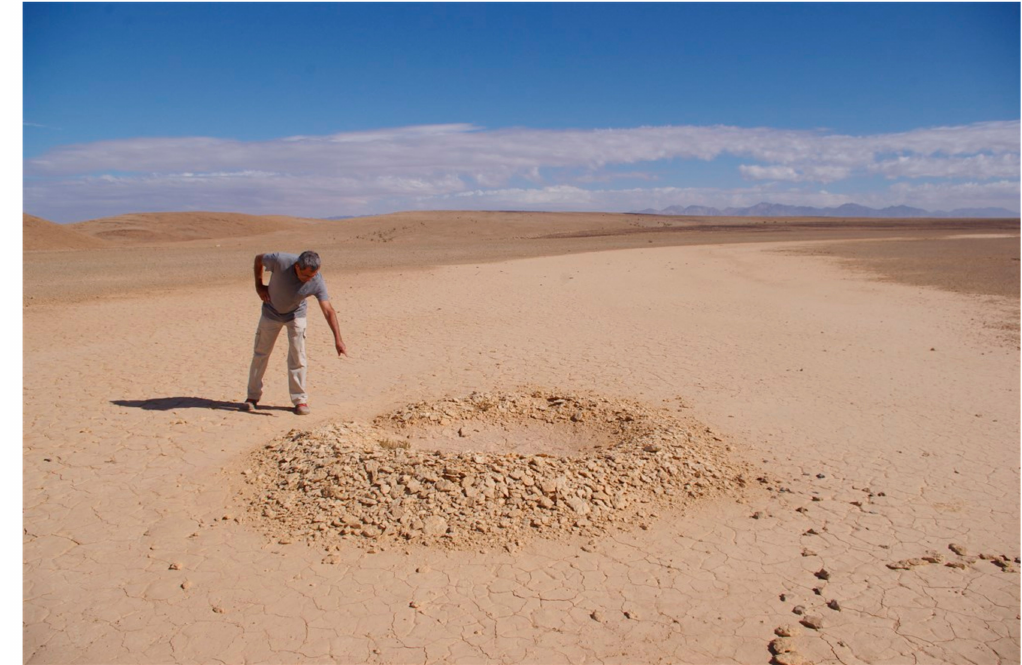
Figure 7. Remains of a cistern-like pit, dug in the Se’ipim Playa’s bed. In the picture, Rahamim Shem-Tov points to the pit’s drainage inlet in the surrounding earth embankment. Picture taken by Ilan